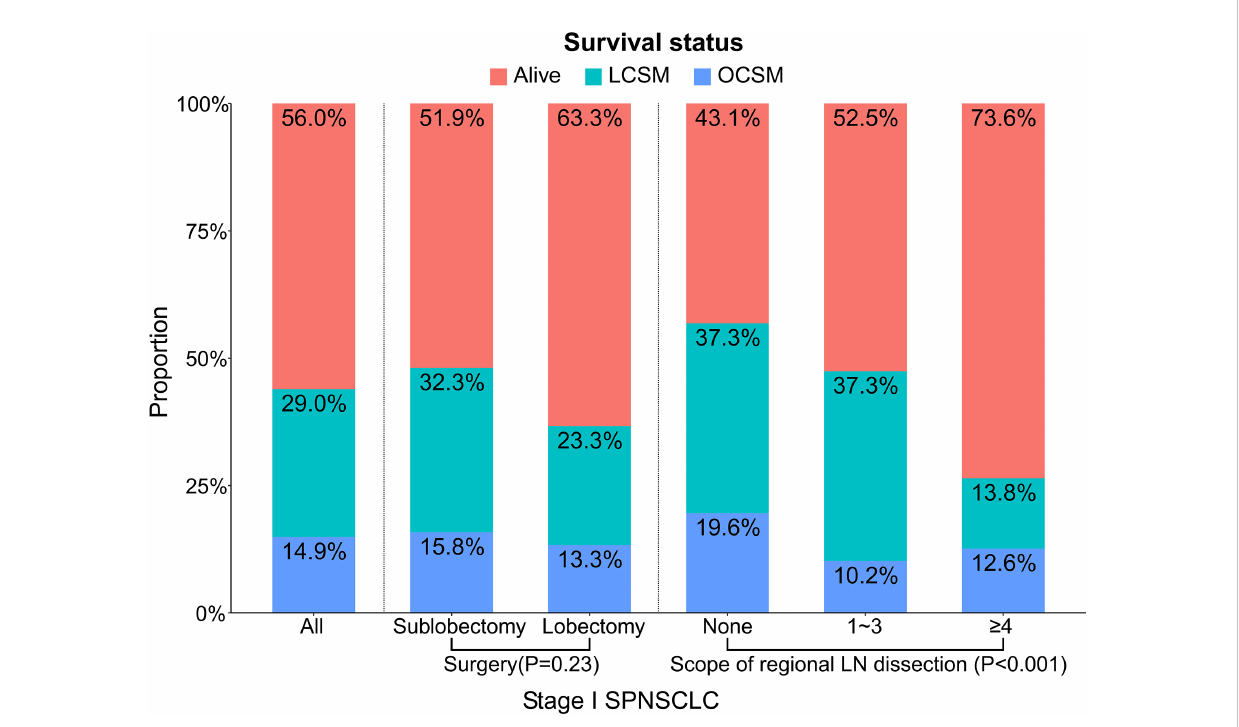
FIGURE 2 Proportions of different survival outcomes by the related variables (surgery and scope of regional LN dissection) in stage I SP patients. A total of three causes of death were investigated: alive, LCSM, OCSM. The statistical differences were tested using chi-squared tests. LCSM, lung cancer- speci fi c morality; LN, lymph node; OCSM, other cause speci fi c mortality; SP, second primary non-small cell lung